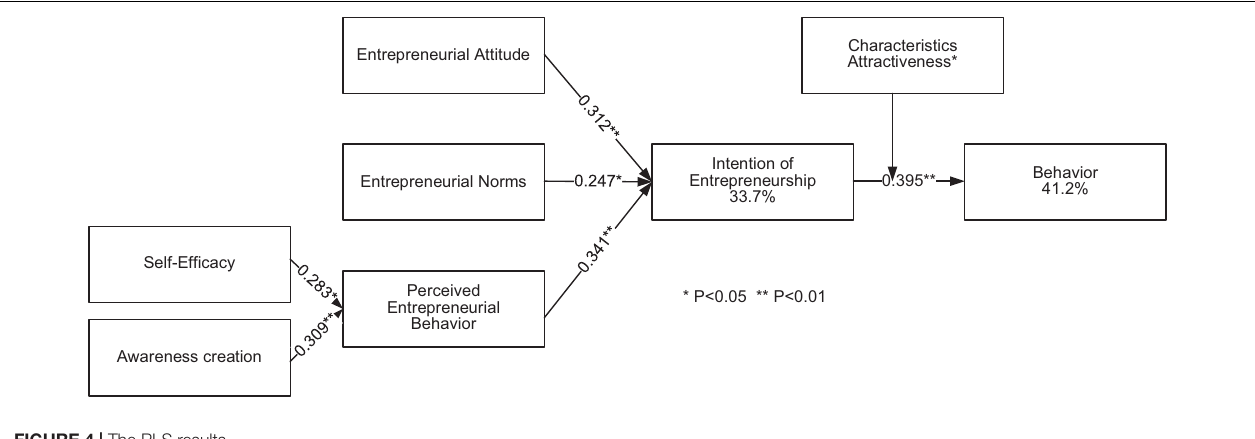
FIGURE 4 | The PLS